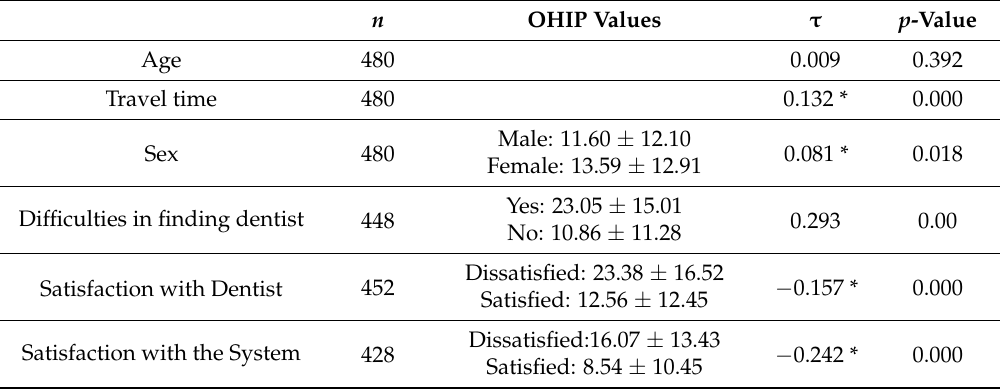
Table 3. Correlation between OHIP values and the patient’s perspective. n = sample size, τ = Kendall’s Tau. OHIP values are shown as mean ± standard